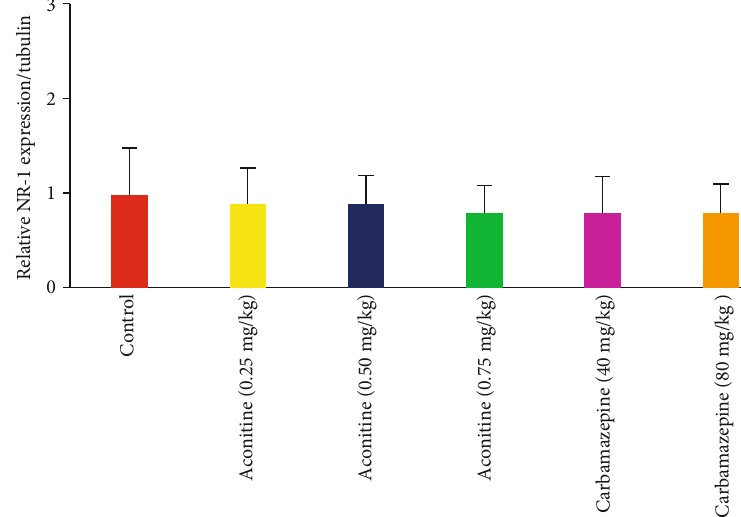
Figure 5: E ff ects of test specimens on NR-1 expression in the contralateral spinal cord in the Western blot